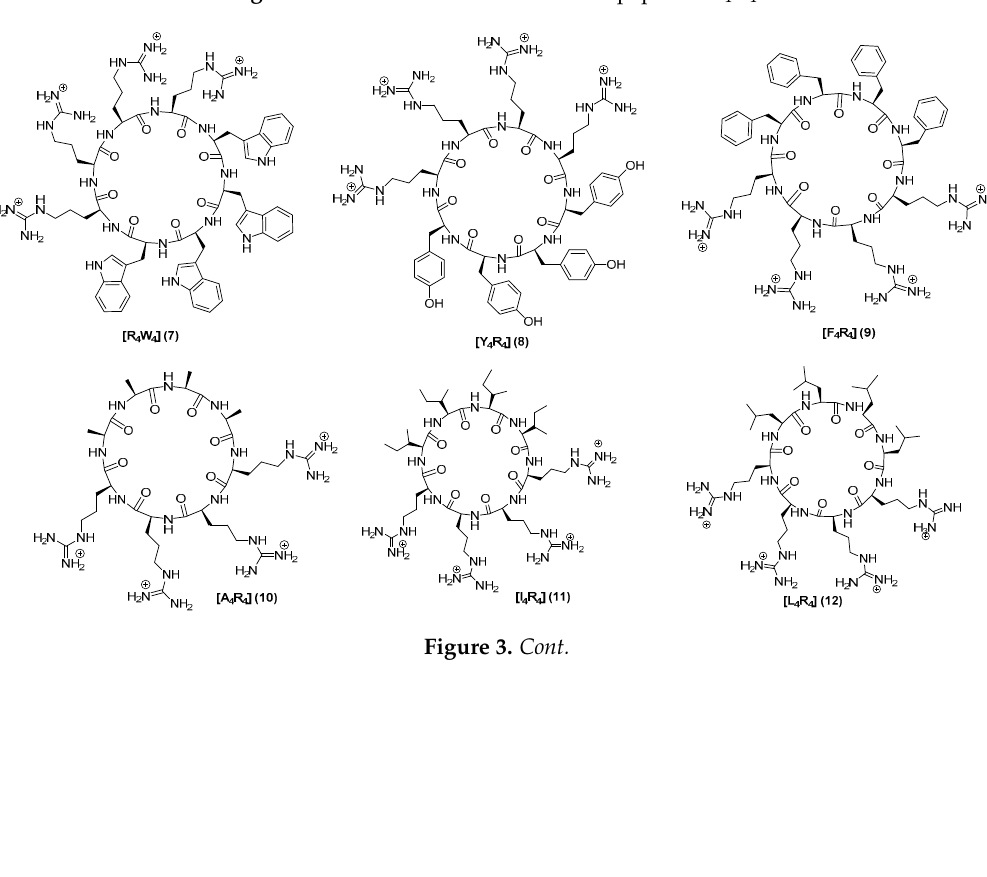
Figure 2. Chemical structures of linear peptides X 4 R 4 .